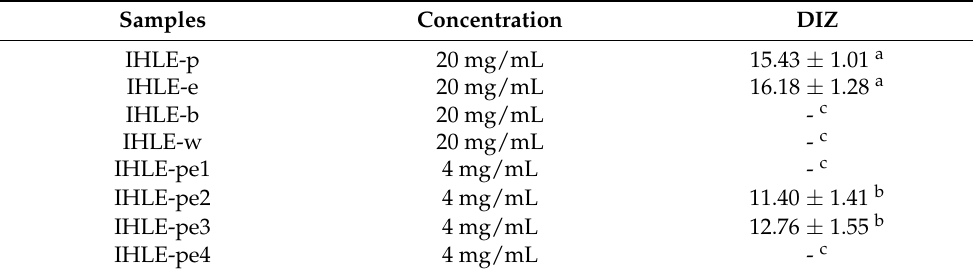
Table 2. The DIZ of E. coli under different fractions of IHLE (mm).